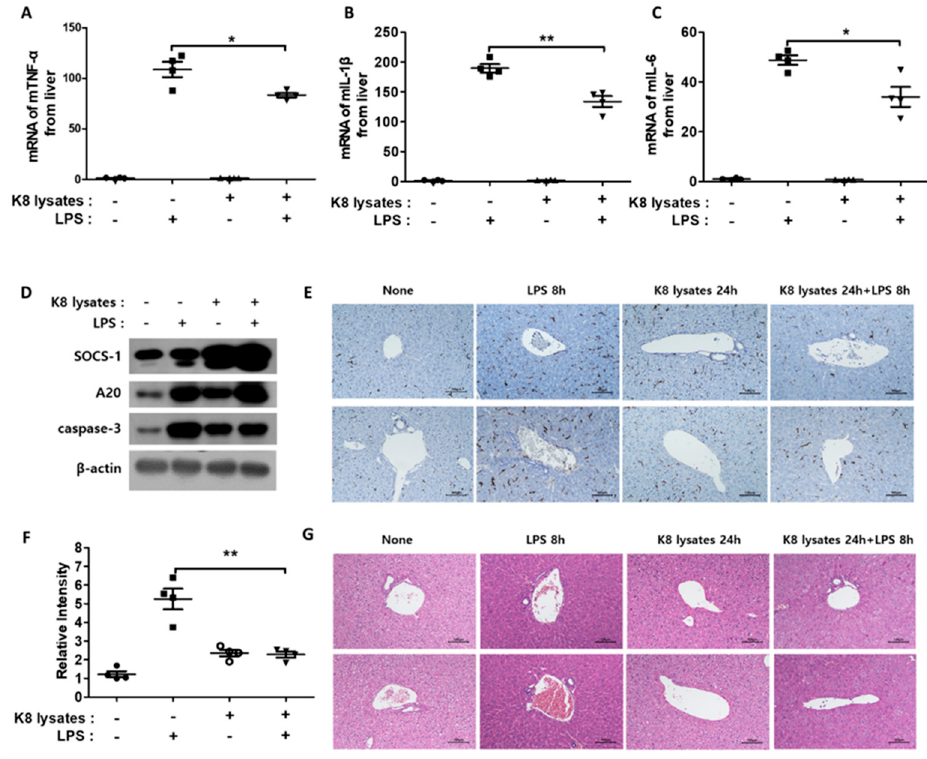
Figure 7. Co-treatment of L. plantarum K8 lysates and LPS reduced liver damage in mice: BALB/C mice (seven-weeks-old, n = 4) were IP injected with 20 mg/kg LPS after IP pre-injection of PBS or 1 × 10 8 CFU/mouse of L. plantarum K8 lysates for 24 h. mRNA and protein were extracted from liver homogenates. The mRNA expressions of TNF- α ( A ) and IL-1 β ( B ), and IL-6 ( C ) were determined by real-time PCR. ( D ) Protein levels of SOCS-1, A20, caspase-3, and β -actin in liver were measured by western blot analysis. ( E ) Immunohistochemistry of F4/80 in livers and ( F ) relative intensity of F4/80. ( G ) Hematoxylin and eosin (H&E) staining of liver from the indicated mice. In ( E , G ), two representative liver images out of four liver samples are shown. Statistical analyses were conducted with an unpaired two-tailed t -test. * p < 0.05; ** p <